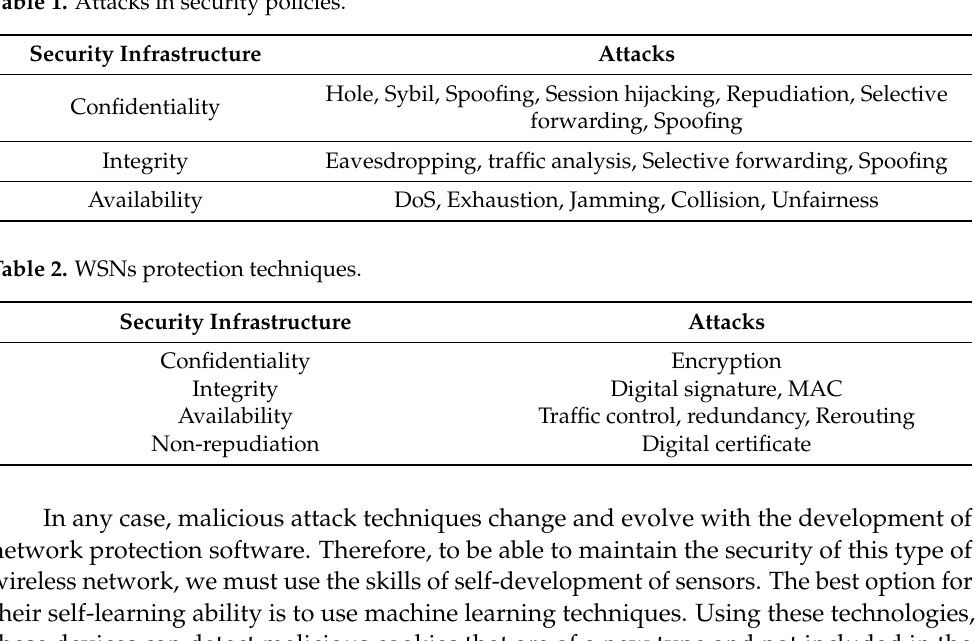
Table 1. Attacks in security policies.